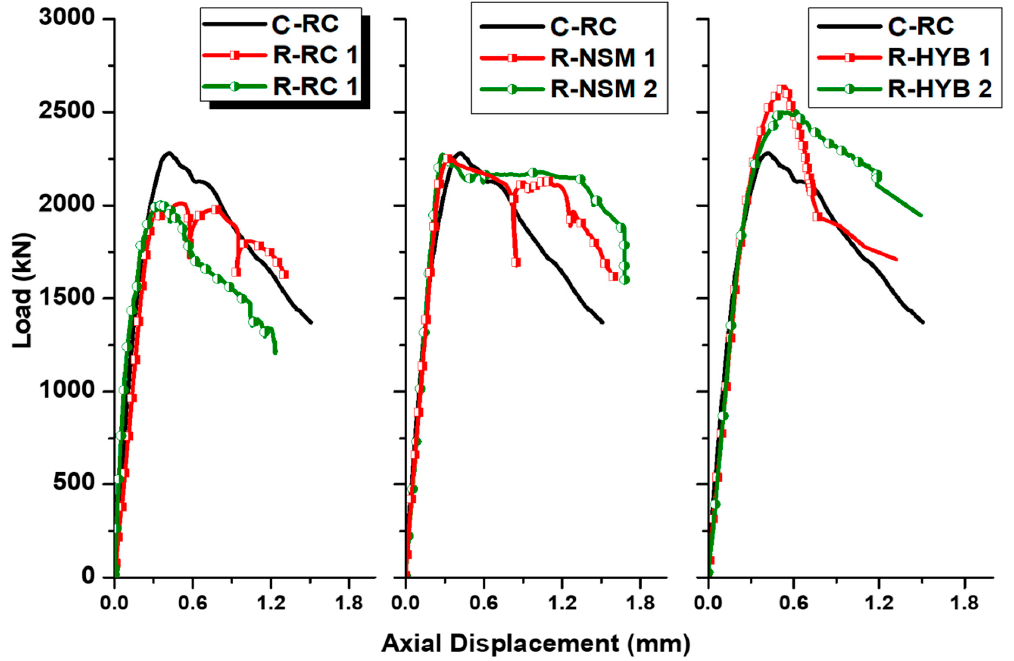
Figure 8. Overall load-displacement behaviour of pre-damaged RC columns.